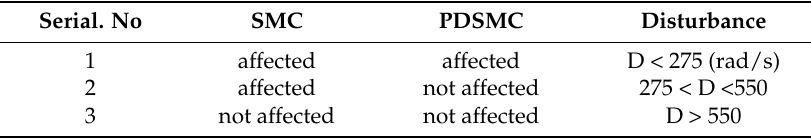
Table 3. Effect of different frequency disturbances in sliding surface.